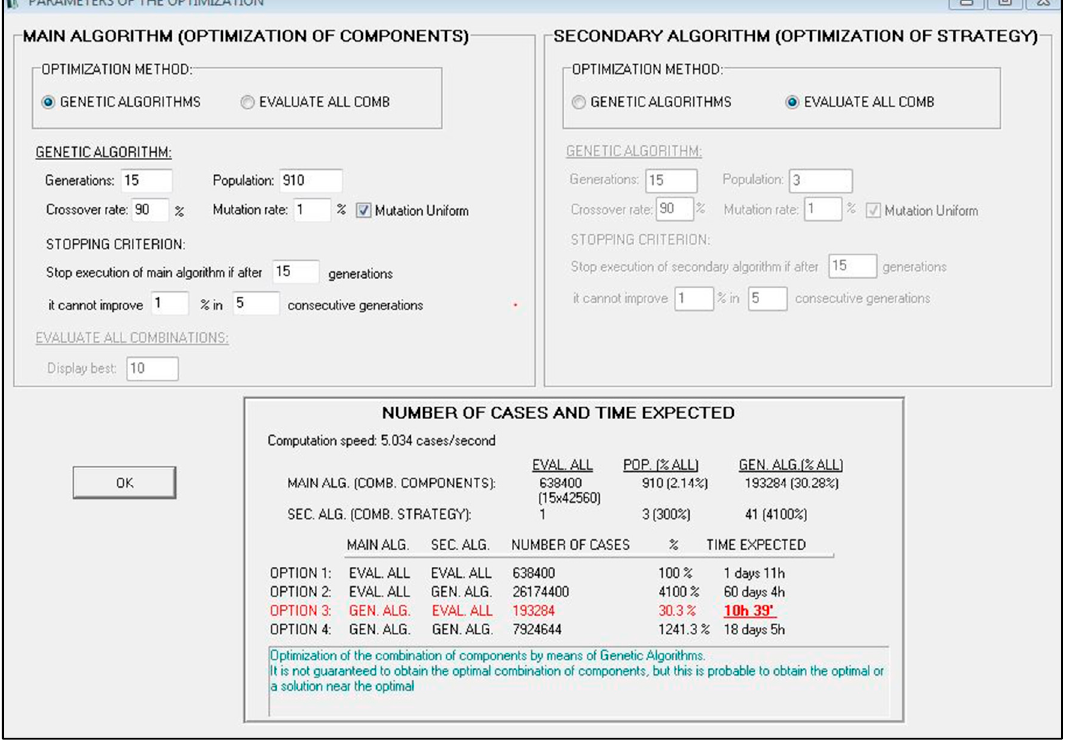
Figure 9. Screenshot of the parameters used for iHOGA simulation.